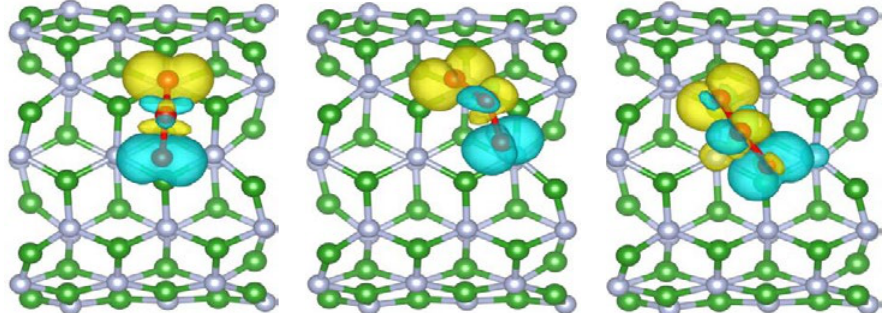
molecule adsorbed on the considered 3